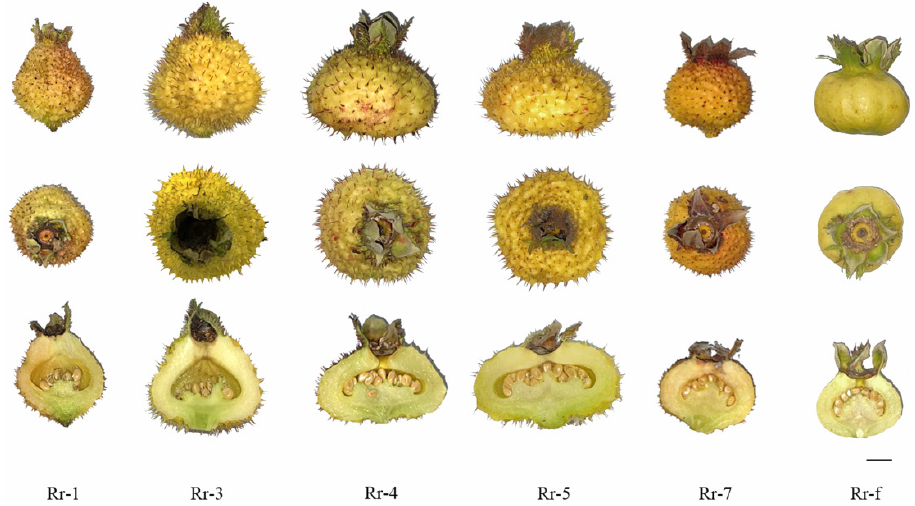
Figure 1. Mature fruits of 6 R. roxburghii genotypes. Scale bar = 1 cm.